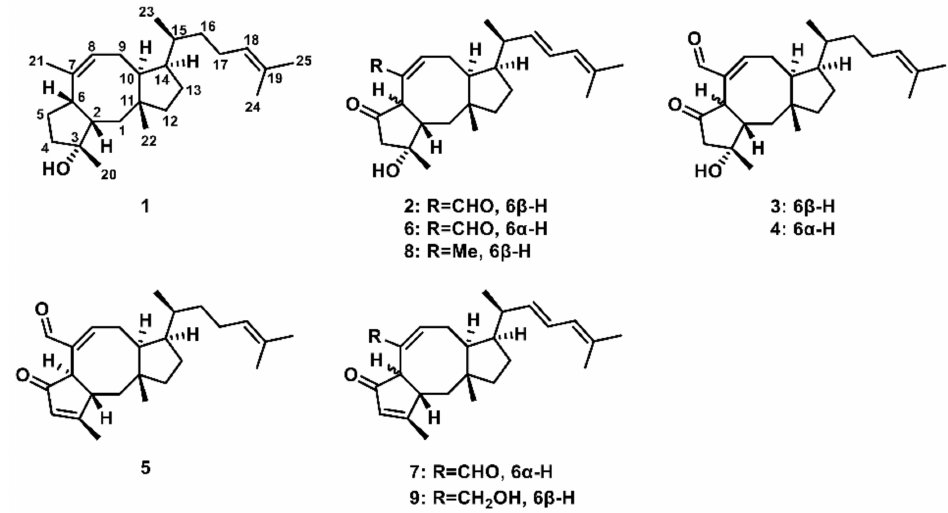
Figure 1. Chemical structure of a part of ophiobolins. Ophiobolin F ( 1 ); ophiobolin K ( 2 ); ophiobolin C ( 3 ); 6-pei-ophiobolin C ( 4 ); 6-epi-ophiobolin N ( 5 ); 6-epi-ophiobolin K ( 6 ); 6-epi-ophiobolin G ( 7 ); 21,21-O-dihydro-6-epi-ophiobolin G ( 8 ); 21-deoxyophiobolin K ( 9